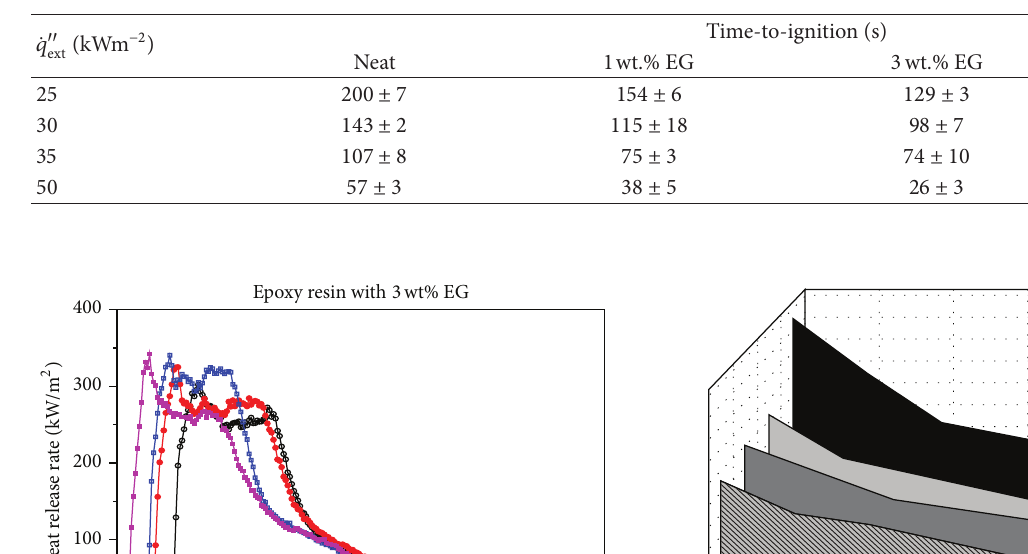
Table 1: Summary of external heat flux and time-to-ignition.